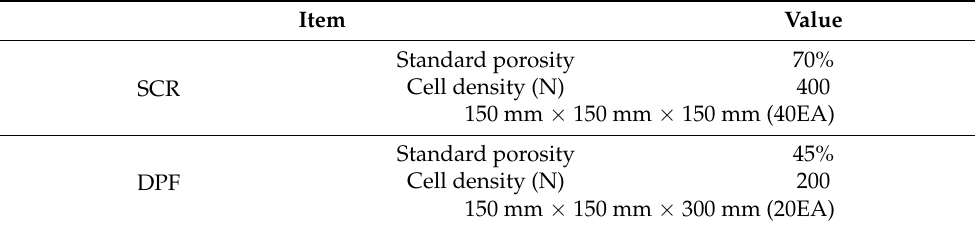
Table 1. Cell zone